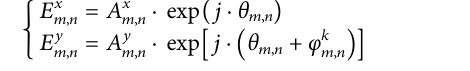
Figure 1A . An illuminator is comprised of dozens of LEDs, which are distributed in several concentric rings. The LEDs on different rings can be chosen independently, so that they can illuminate a sample at different angles. All LEDs used are identical and have a narrow spectrum band (470 ± 10 nm, central wavelength ± half- width). For CF-QPCM imaging, only the LEDs on one ring are lit up simultaneously to achieve off-axis illuminations. The emitted light from the LEDs directly illuminates the sample, which is placed at the front focal plane of the objective lens (Leica, ×100/ 1.44 Oil Immersion, WD-0.17, Germany). After passing through the sample, an object wave is formed, which carries the structural and compositional information of the sample. The object wave can be divided into scattered and unscattered waves.